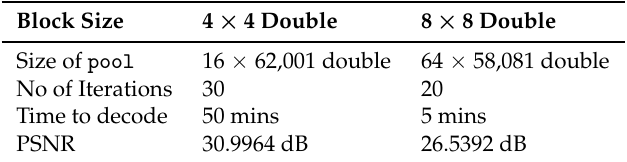
Table 3. 256 × 256 Cat image reconstructed from fractal image representation using range block size of 4 × 4 and 8 × 8, respectively, with the decoding process begins with a zero matrix initial reference